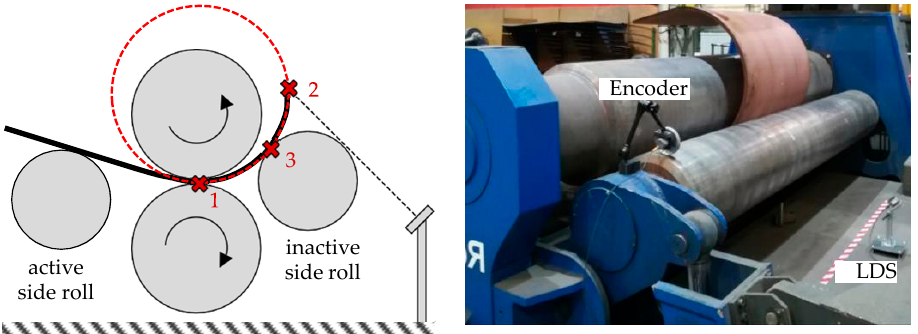
Figure 6. Working principle of the developed monitoring system.